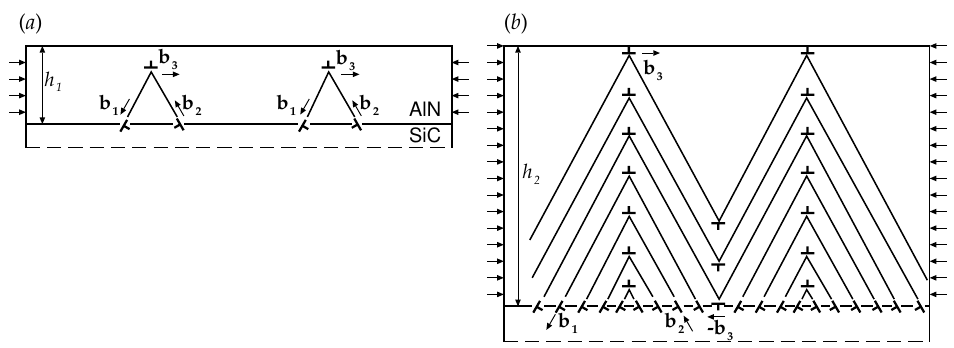
Figure 9. Theoretical model of the formation of misoriented domains separated from each other by tilt low-angle boundaries composed of ± b 3 -dislocations in an AlN layer on an SiC substrate. ( a ) a couple of neighboring Λ -shaped MD configurations in the vicinity of the AlN/SiC interface, generated at h = h 1 > h c as described in Ref. [15]; ( b ) two neighboring ’matrioshkas’ of Λ -shaped MD configurations in contact, separated by a wall of − b 3 -dislocations accidentally created in reactions of meeting b 1 - and b 2 -dislocations at h = h 2 >> h 1